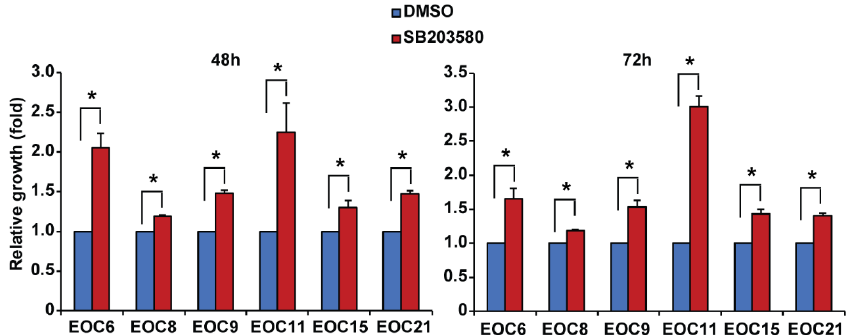
Figure 4. Inhibition of p38 MAPK by SB203580 increases the number of viable cells in primary EOC cells. Primary EOC cells were cultured in adherent condition and treated with 10 μ M SB203580 or an equal volume of DMSO (the vehicle control). Viable cells were measured at 48 and 72 h using the neutral red uptake assay and expressed as fold changes (SB203580 versus DMSO). Data are shown as mean ± SE of three independent experiments. * Significantly different ( p < 0.05).